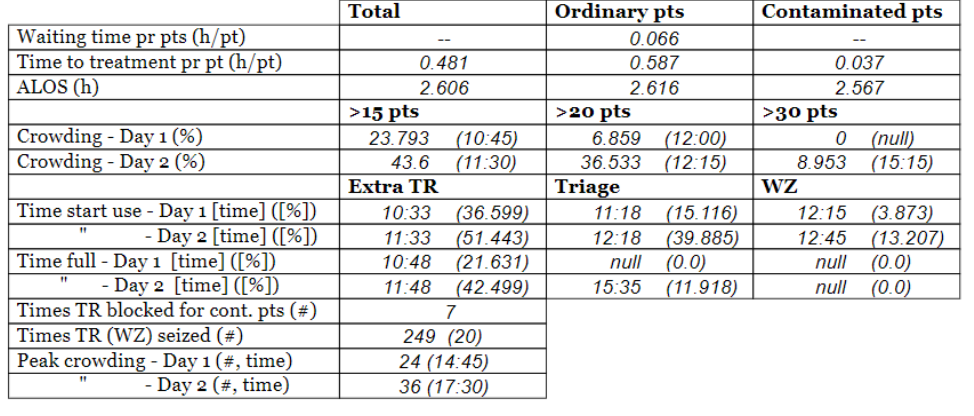
Figure 16. Snapshot of simulated KPI of patient flow in a pre-pandemic setting.